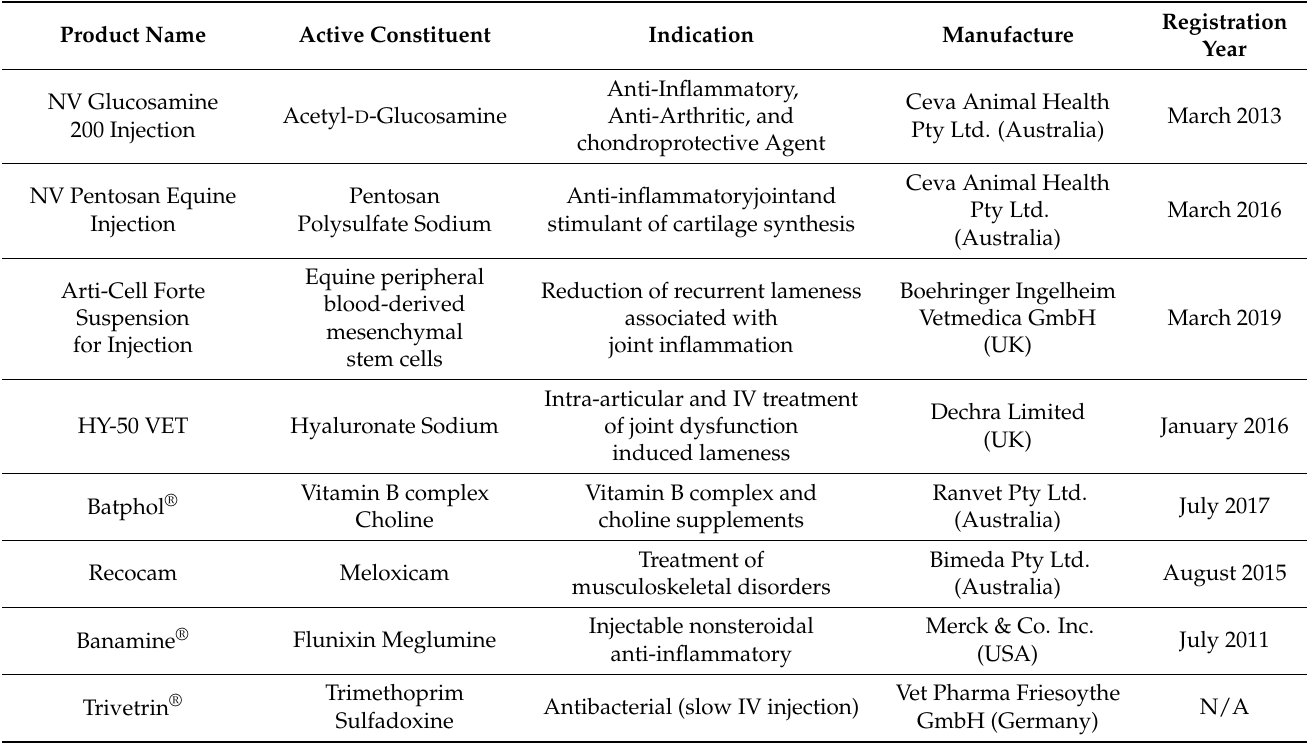
Table 5. Examples of Marketed/Registered equine injectable products and their